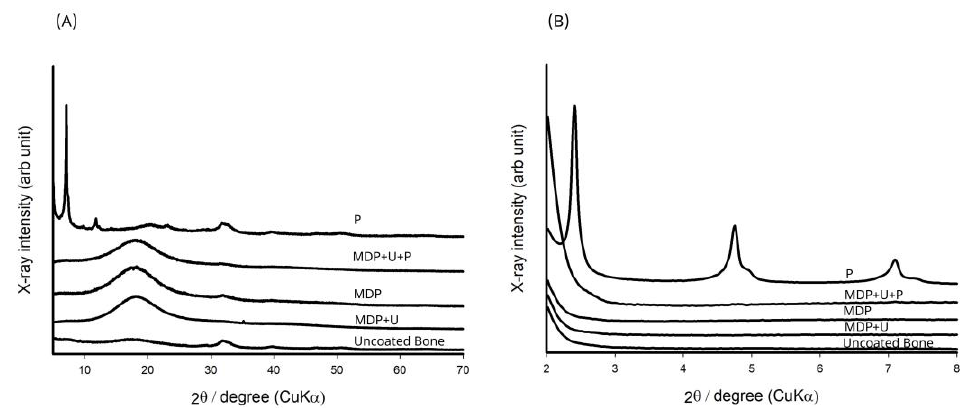
Figure 4. ( A ) XRD analysis of the adhesive monomers interacting with the bone substrate. ( B ) Mag- nified image of the area between 2° and 8° in ( A ) revealing interactions of the primer layer (P) with bone.